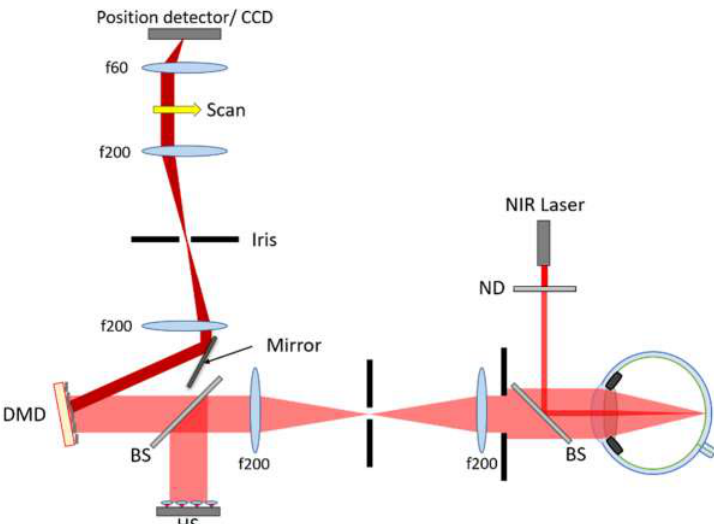
Figure 1. Schematic of the system used to measure ocular aberrations using a digital micromirror devices (DMD). A 4 mm beam of near-infrared (IR) light backscattered from the retina is sequentially scanned in the pupil plane by the DMD, which directs light onto a position detector via a plane mirror to capture the maximum light. The detector captures the ( x , y ) centroid coordinates of the point-spread-function (PSF) in the case of the lateral position detector, or captures images of the PSF in case of the charge-coupled device (CCD) camera, for each scanned section of the light. All lenses used are antireflection-coated achromatic doublets.